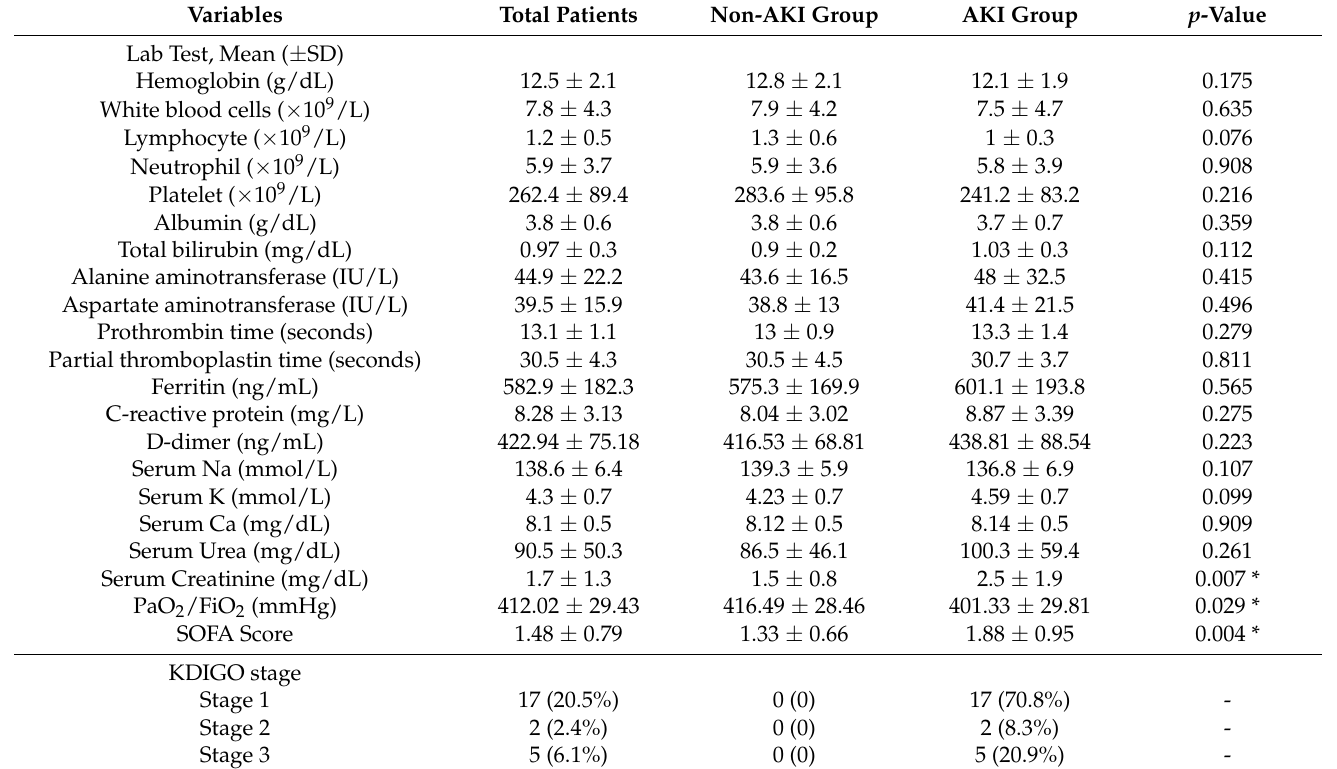
Table 4. Laboratory indices of COVID-19 patients on admission.